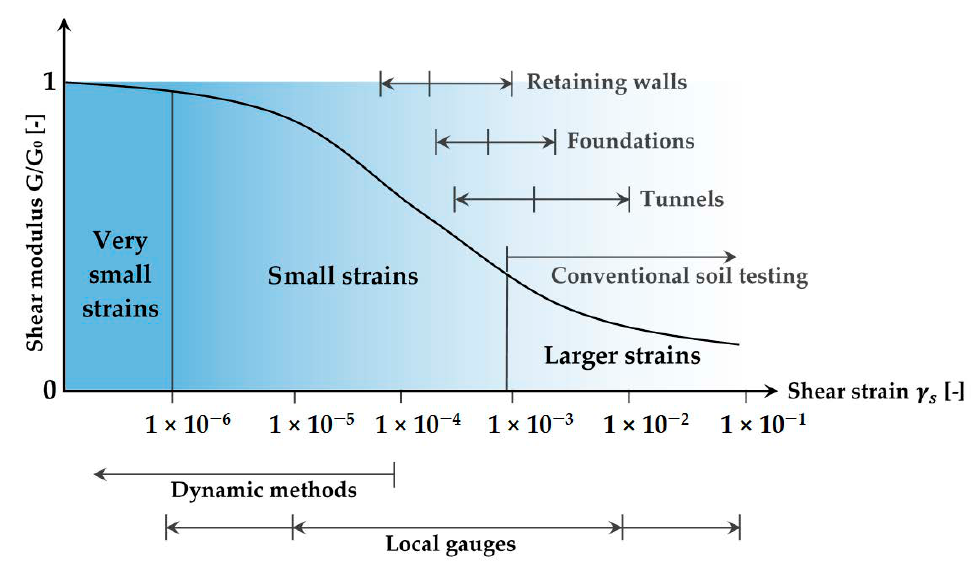
Figure 4. Characteristic stiffness–strain behavior of soil with typical strain ranges for laboratory tests and structures. Table 2. Speswhite kaolin clay parameters for numerical method verification.